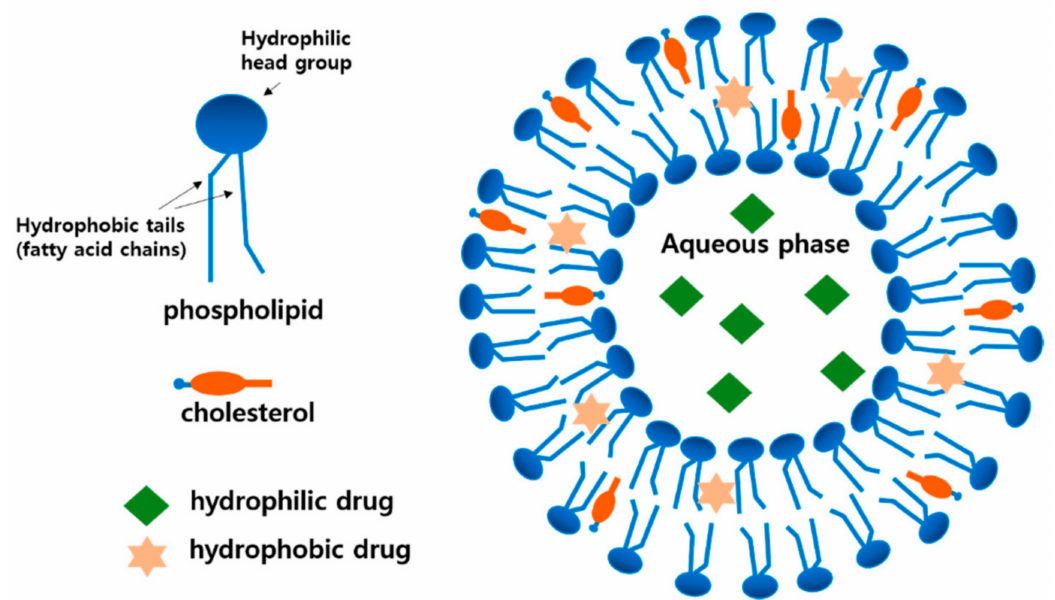
Figure 5. Liposome’s structure characterized by a spherical vesicle with a phospholipid bilayer membrane used to deliver hydrophilic or hydrophobic drug. Reproduced with permission from